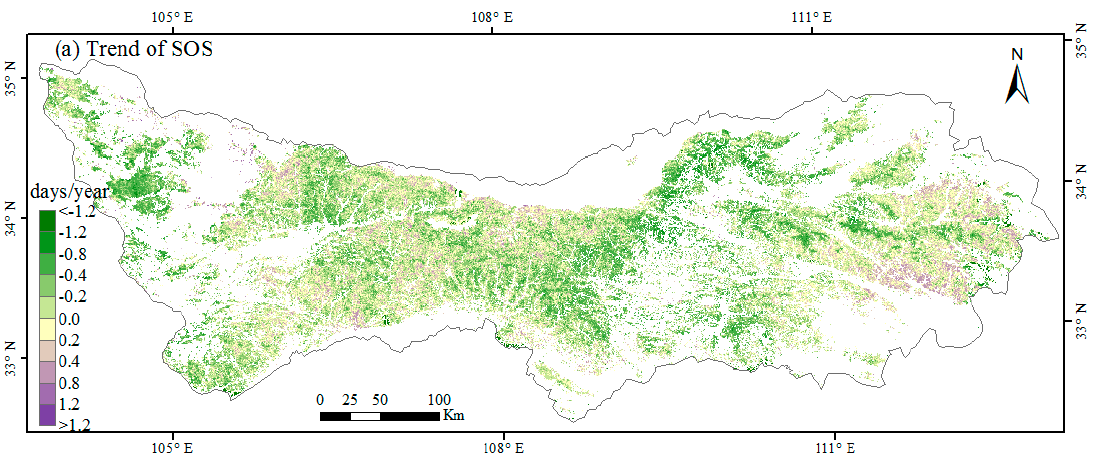
Figure 4. Interannual changes in the mean of the regional-scale SOS ( a ), EOS ( b ), and LOS ( c ). Standard deviation (SD) is indicated by error bars. The red line is the linear fitted line, and the gray section is the confidence level at 95%.